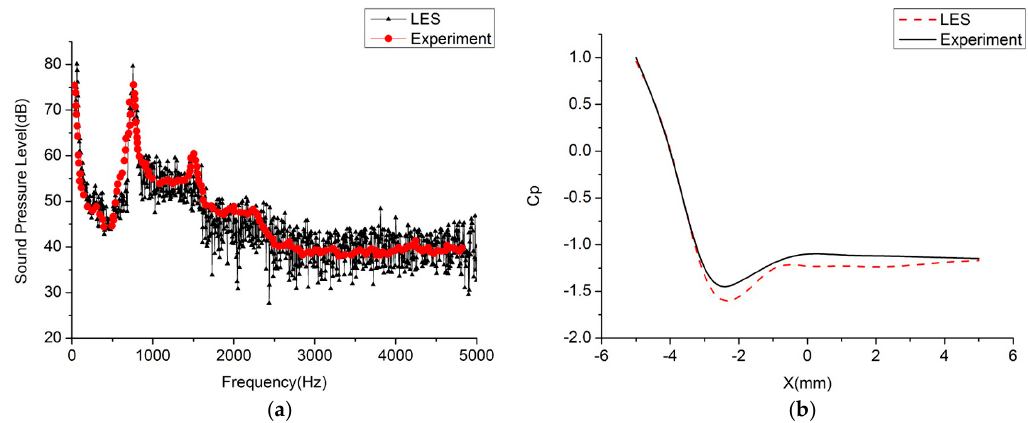
Figure 6. Comparison of numerical predictions with experimental measurements. ( a ) Sound pressure spectra; and ( b ) pressure coefficient ( C p ).